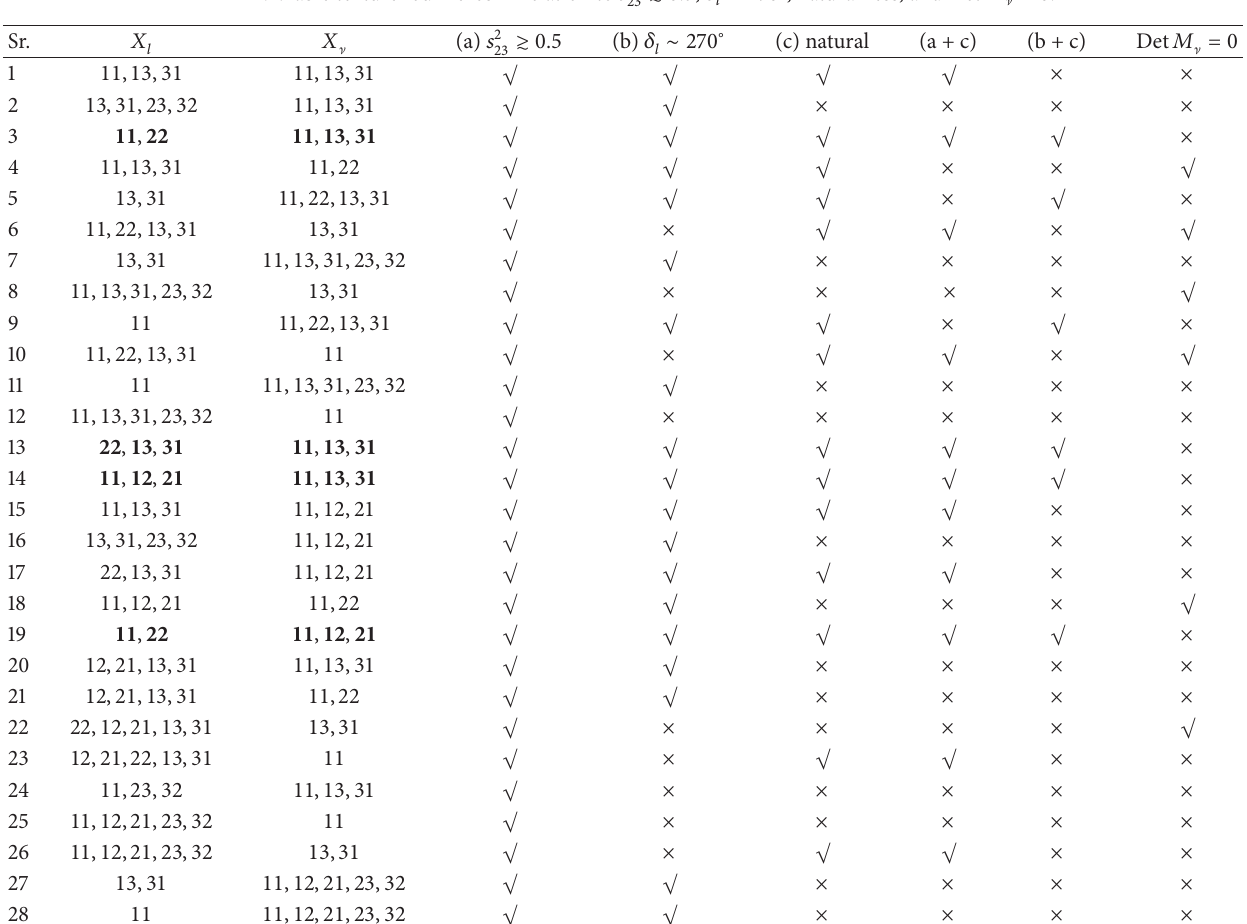
Table 2: Viable texture four zeros in relation to 𝑠 2 23 ≳ 0.5 , 𝛿 𝑙 ∼ 270 ∘ , naturalness, and Det 𝑀 ] = 0 .